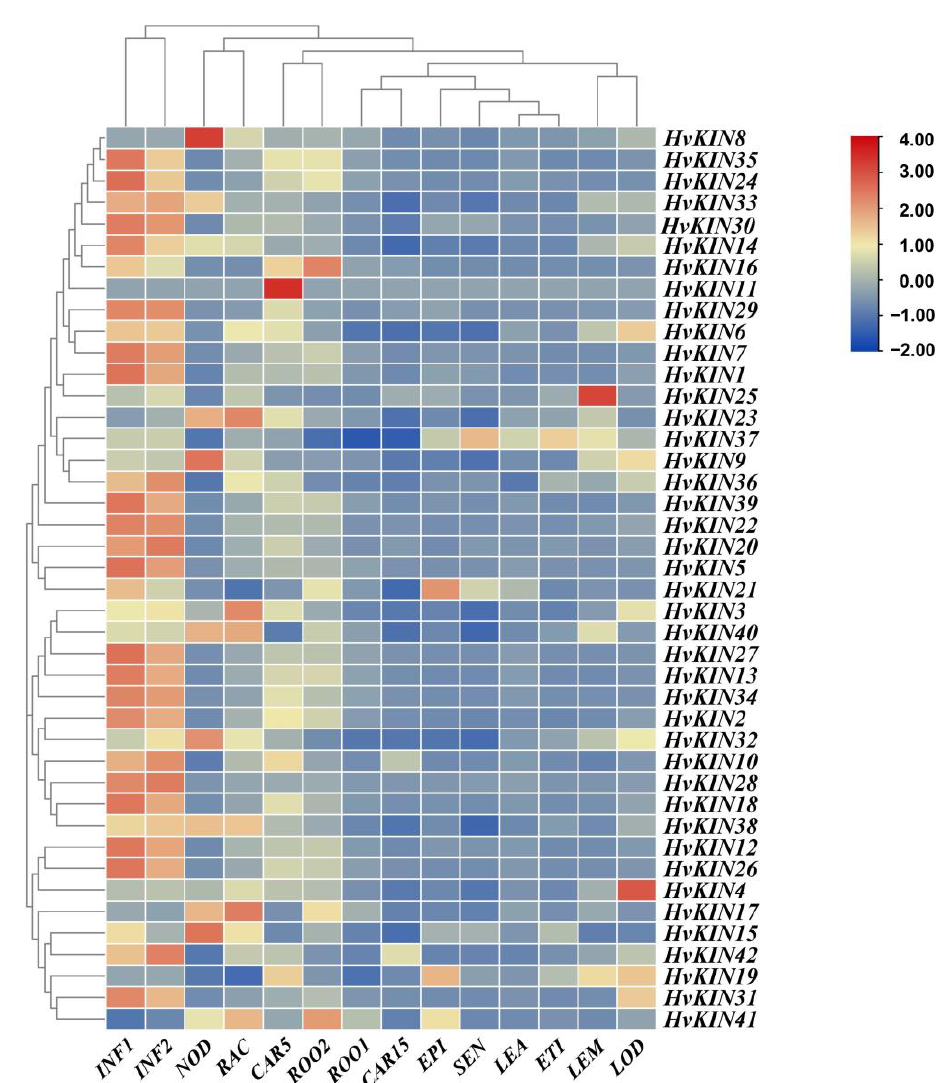
Figure 8. Expression profiles of a subset of HvKIN s. A graduated color scale from blue to red is used to denote the transcript levels. Expression data were retrieved from IPK (https://apex.ipk- gatersleben.de/apex/f?p=284:10 access on 22 January 2022). The subset of HvKIN genes’ hierarchical clustering and normalized expression levels were both adjusted using logarithmic functions. The heatmap was produced using the TBtools software. INF1: Young developing inflorescences (5 mm); INF2: Developing inflorescences (1 – 1.5 cm); NOD: Developing tillers, 3rd internode (42 DAP); RAC: Inflorescences, rachis (35 DAP); CAR5: Developing grain (5 DAP); ROO2: Roots (28 DAP); ROO1: Roots from seedlings (10 cm shoot stage); CAR15: Developing grain (15 DAP); EPI: Epidermal strips (28 DAP); SEN: Senescing leaves (56 DAP); LEA: Shoots from seedlings (10 cm shoot stage); ETI: Etiolated seedling, dark cond. (10 DAP); LEM: Inflorescences, lemma (42 DAP); LOD: Inflorescences, lodicule (42 DAP).